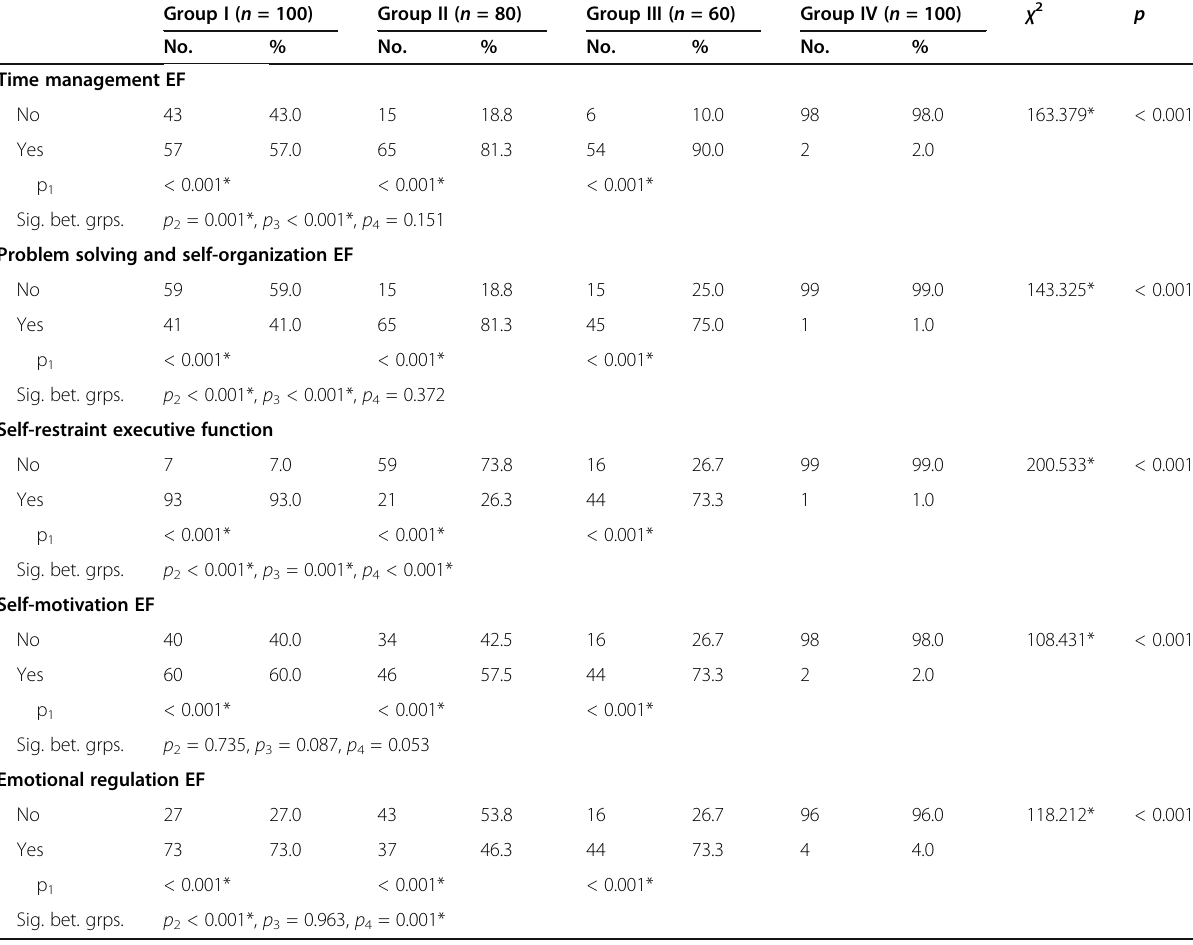
Table 1 Comparison between the different studied groups according to different executive functions domains Group I ( n = 100) Group II ( n =